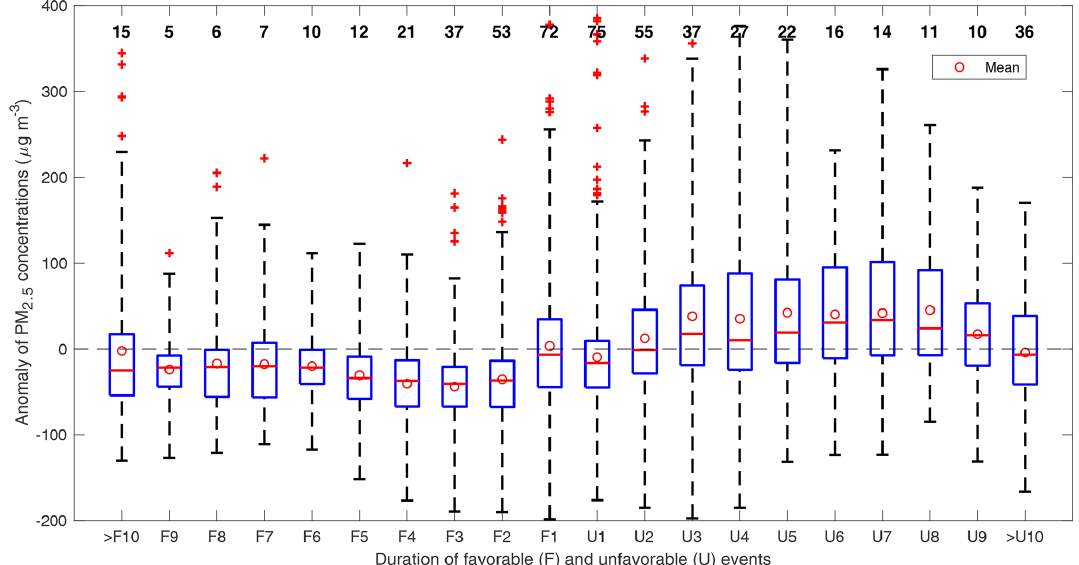
Figure 8. The daily PM 2 . 5 concentration anomalies vary with favorable (F) and unfavorable (U) event durations. The occurrences of CT1 and CT2 are collectively called favorable events, and CT3 to CT6 are referred to as unfavorable events. U1 indicates an unfavorable circulation event lasting for 1d, and U2 means a 2d event. The central red line in each box indicates the median, and the circle is the mean